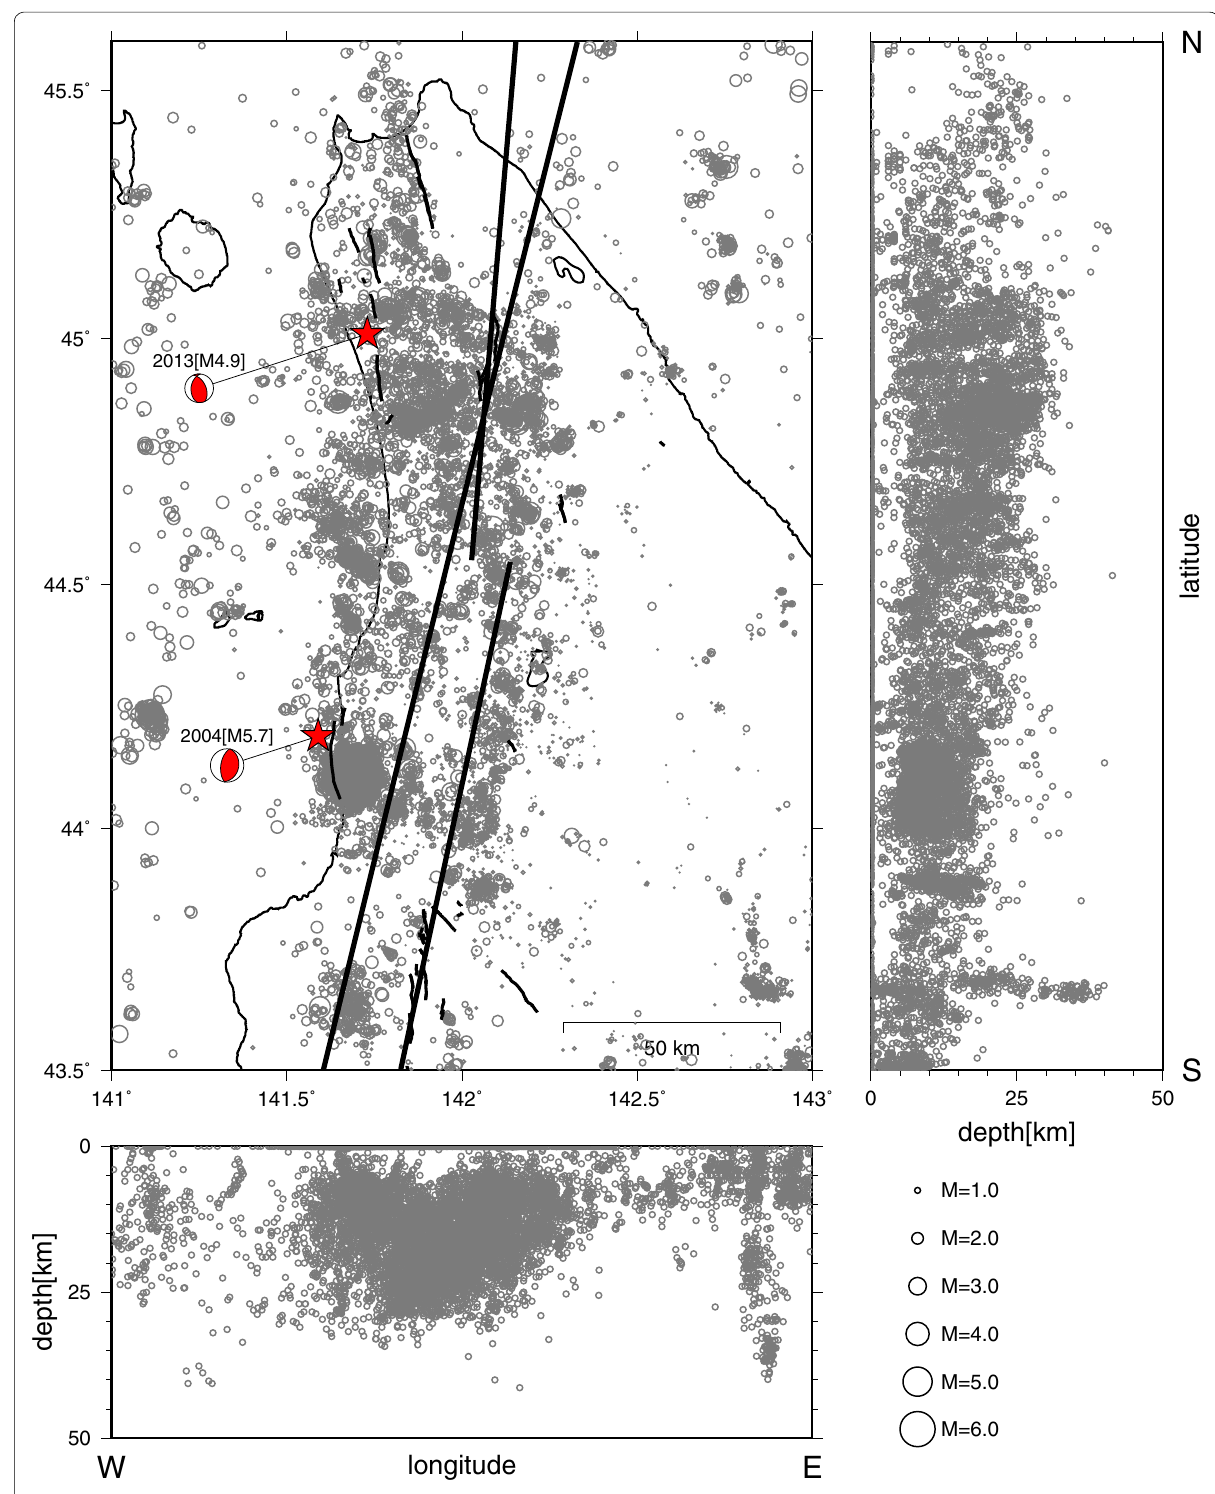
Fig. 4 Seismicity map of northern Hokkaido. The epicenters of earthquakes from 1997 to 2016 are plotted based on the catalog obtained from the Japan Meteorological Agency (2019). The solid lines indicate the estimated location of the boundary in each area (same as in Fig.